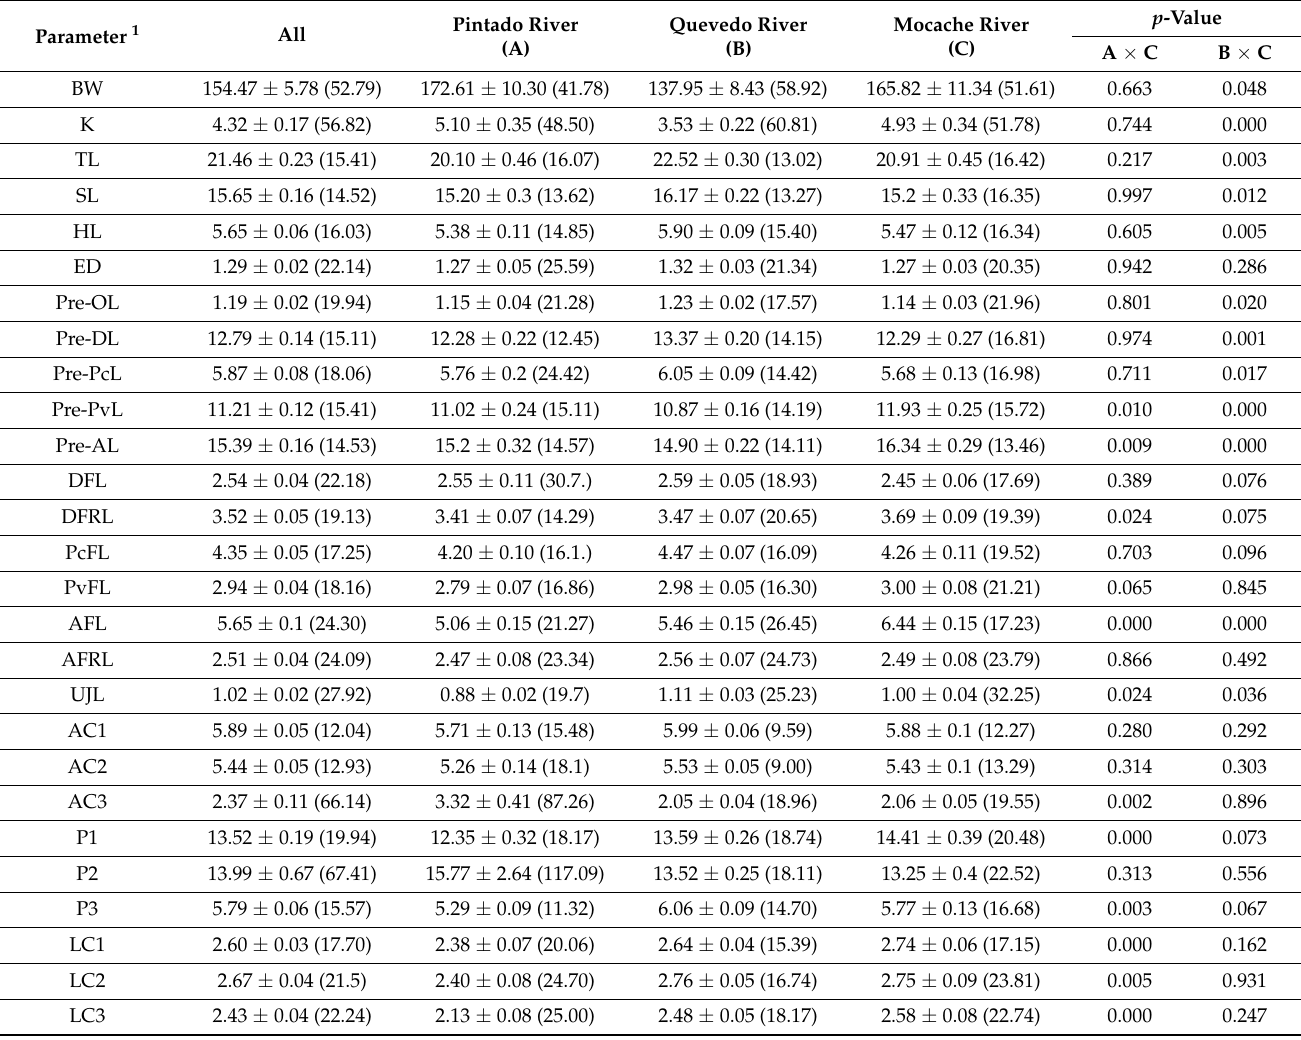
Table 3. Descriptive statistics for body measurements (original data) in three populations of Brycon dentex (Mean ± SE (CV, %)). Parameter